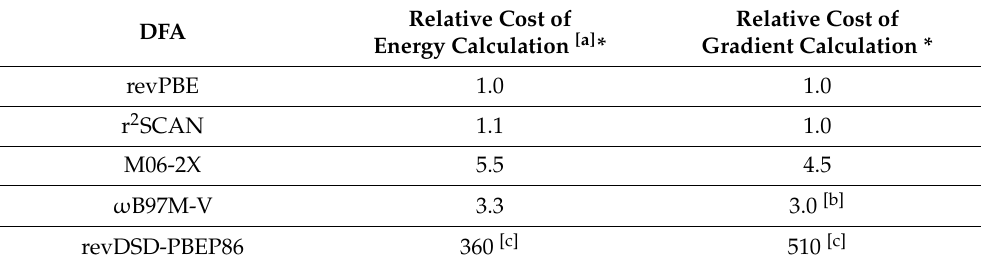
Table 3. The relative computational cost of selected DFA from Table 1.